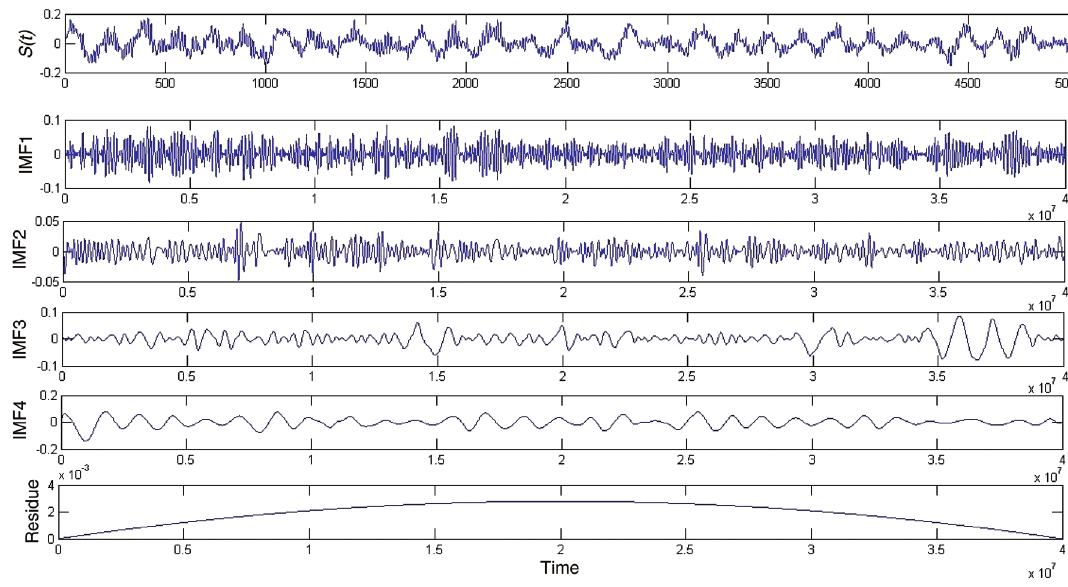
Figure 2. Decomposition of the Music Fragment S ( t ) into IMF Components and Residue Using EMD [20].